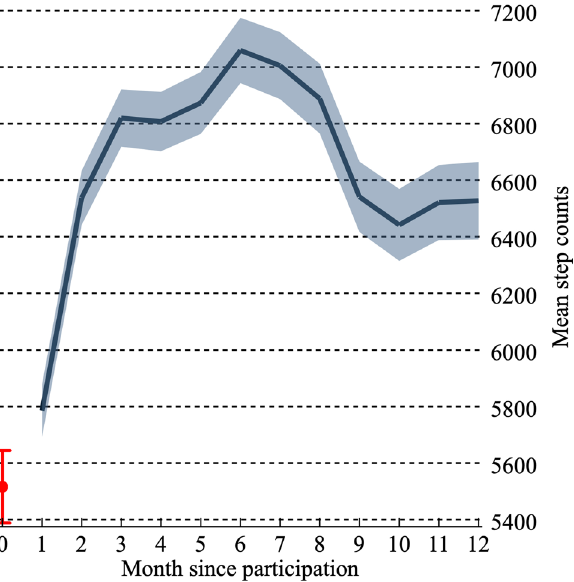
Figure 1. Mean step counts after participation in the e-wellness project. The red marker with the error bar represents mean step counts and the 95% confidence interval among the participants at the baseline. Navy lines represent mean step counts after participation in the e-wellness project, with shaded areas showing the 95% confidence intervals among the participants. Sample sizes for each month step counts range from 1,115 to 1,536. This figure was created by the Stata software, version 16.1.